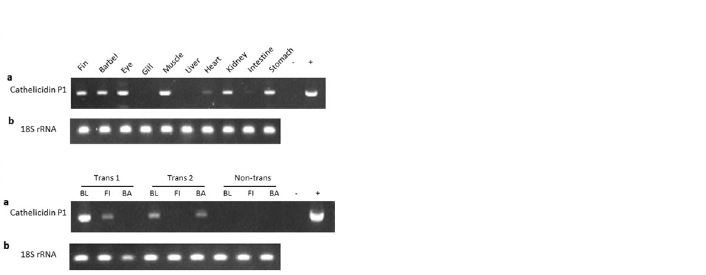
donor oligonucleotide targeting C13H9orf72 genomic locus but only 1.7% showed correct knock-in without